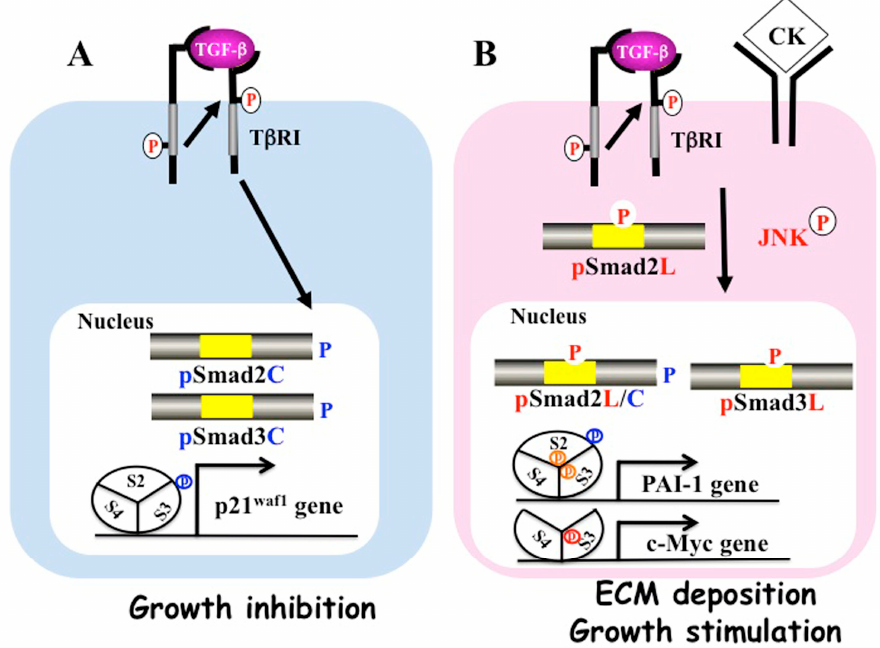
Figure 1. Differential phospho-Smad signals between tumor suppression and fibrocarcinogenesis. ( A ) Activated transforming growth factor (TGF)- β type I receptor (T β RI) phosphorylates COOH-tail serine residues of Smad2 and Smad3. Both COOH-terminally phosphorylated Smad2/3 (pSmad2C and pSmad3C) translocate with Smad4 to the nuclei of quiescent hepatocytes after regeneration. Smad2/3/4, complex binds the p21 waf1 promoter and suppresses cell growth; ( B ) Pro-inflammatory cytokines (CK) such as tumor necrosis factor- α activate c-Jun N-terminal kinase (JNK), which phosphorylates the linker regions of Smad2 and Smad3. Linker phosphorylated Smad3 (PSmad3L) translocates with Smad4 to the nucleus and binds plasminogen activator inhibitor type 1 (PAI-1) promoter. Linker phosphorylated Smad2 (PSmad2L) is localized in the cytoplasm, and Smad2 translocates to the nucleus only after COOH-tail phosphorylation by T β RI. PSmad2L/C in cooperation with pSmad3L and Smad4 stimulate PAI-1 transcription and extracellular matrix (ECM) deposition. PSmad3L up-regulates c-Myc and stimulates cell growth, while suppressing the pSmad3C-mediated tumor suppressive pathway.